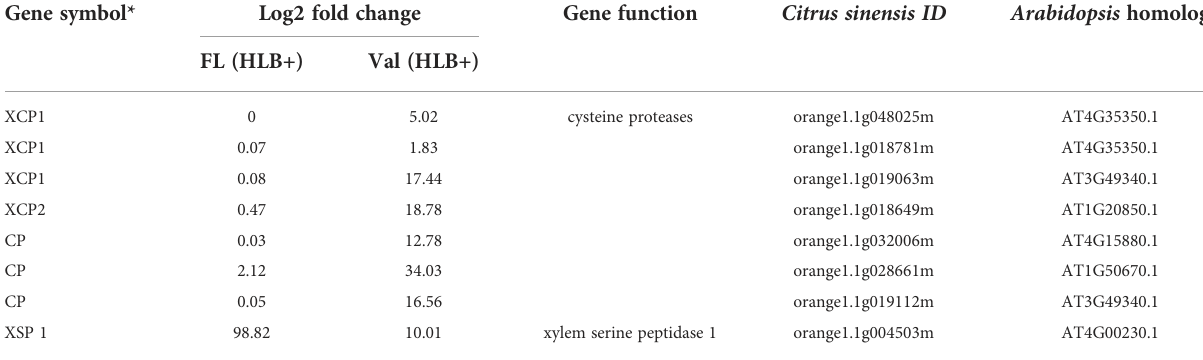
TABLE 5 DEGs involved in cysteine protease production in fi nger lime and ‘ Valencia ’ sweet